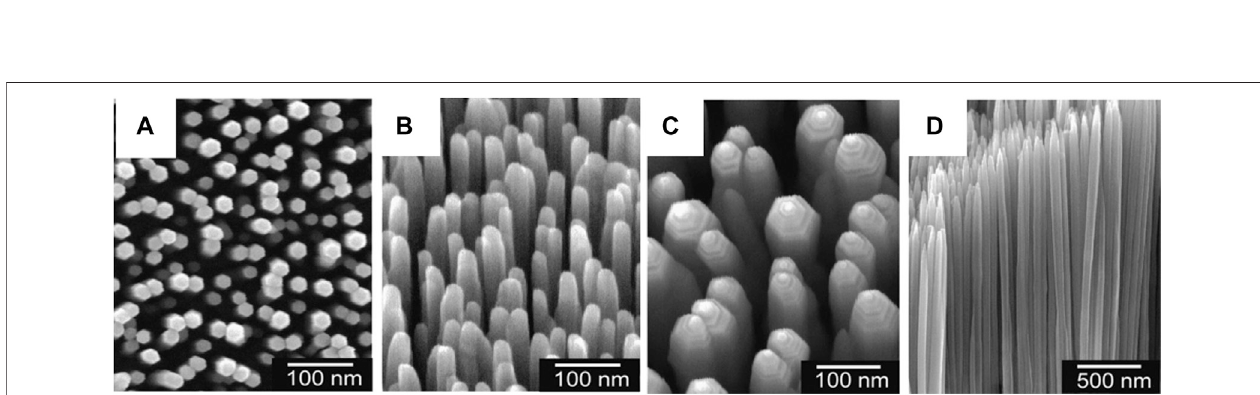
FIGURE 10 | (A) FESEM image of ZnO Nanorods (Bhat, 2008); SEM image of Seed layer (B) and ZnO nanorods (C) (Yu et al., 2009); (D) SEM image of ZnO nanorods formed (Li et al.,